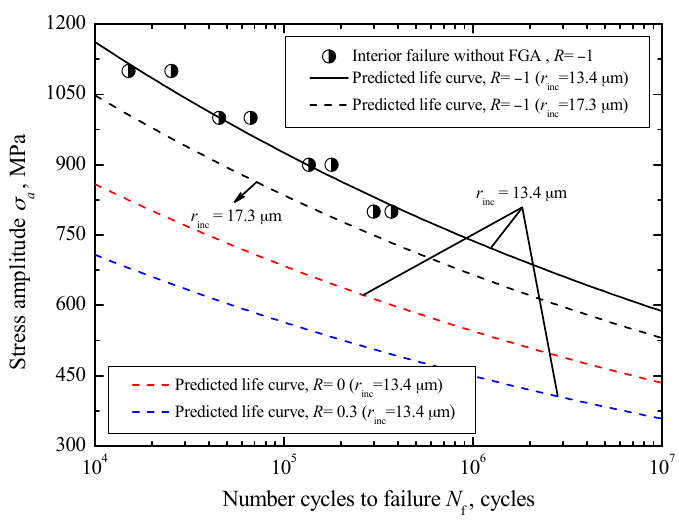
Figure 14. Predicted crack growth lives for interior failure without FGA.